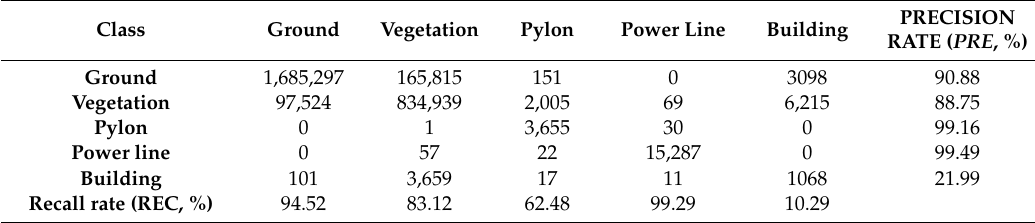
Table 5. The confusion matrix and performance measures of site I (classifier = RF, feature set = F 0 , class distribution = unbalanced, R = 1.5 m).